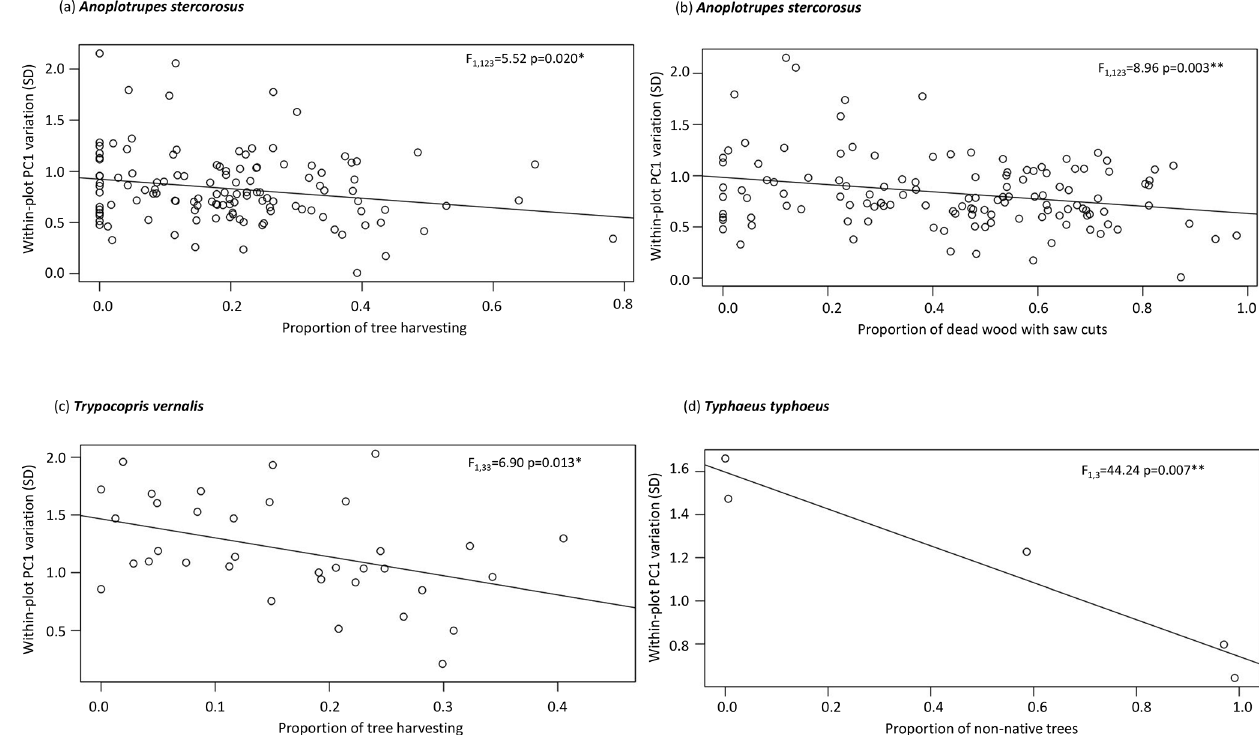
Figure 3. Within-plot variation of relative morphological PC scores in (a–b) Anoplotrupes stercorosus , (c) Trypocopris vernalis , and (d) Ty- phaeus typhoeus in relation to the proportion of tree harvesting, dead wood with saw cuts, and non-native trees. Note the different scales. Abbreviations: ∗ = p ≤